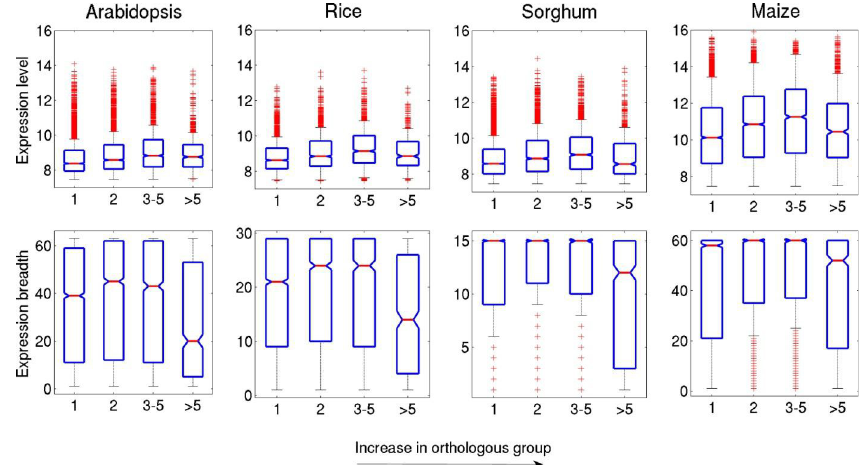
Fig 8. The relationship between size of orthologous group and expression level and expression breadth. Top and bottom spaces of the box are 25th and 75th percentiles of the dataset. Here the mid line of the box represents the median position and the outliers are presented in red